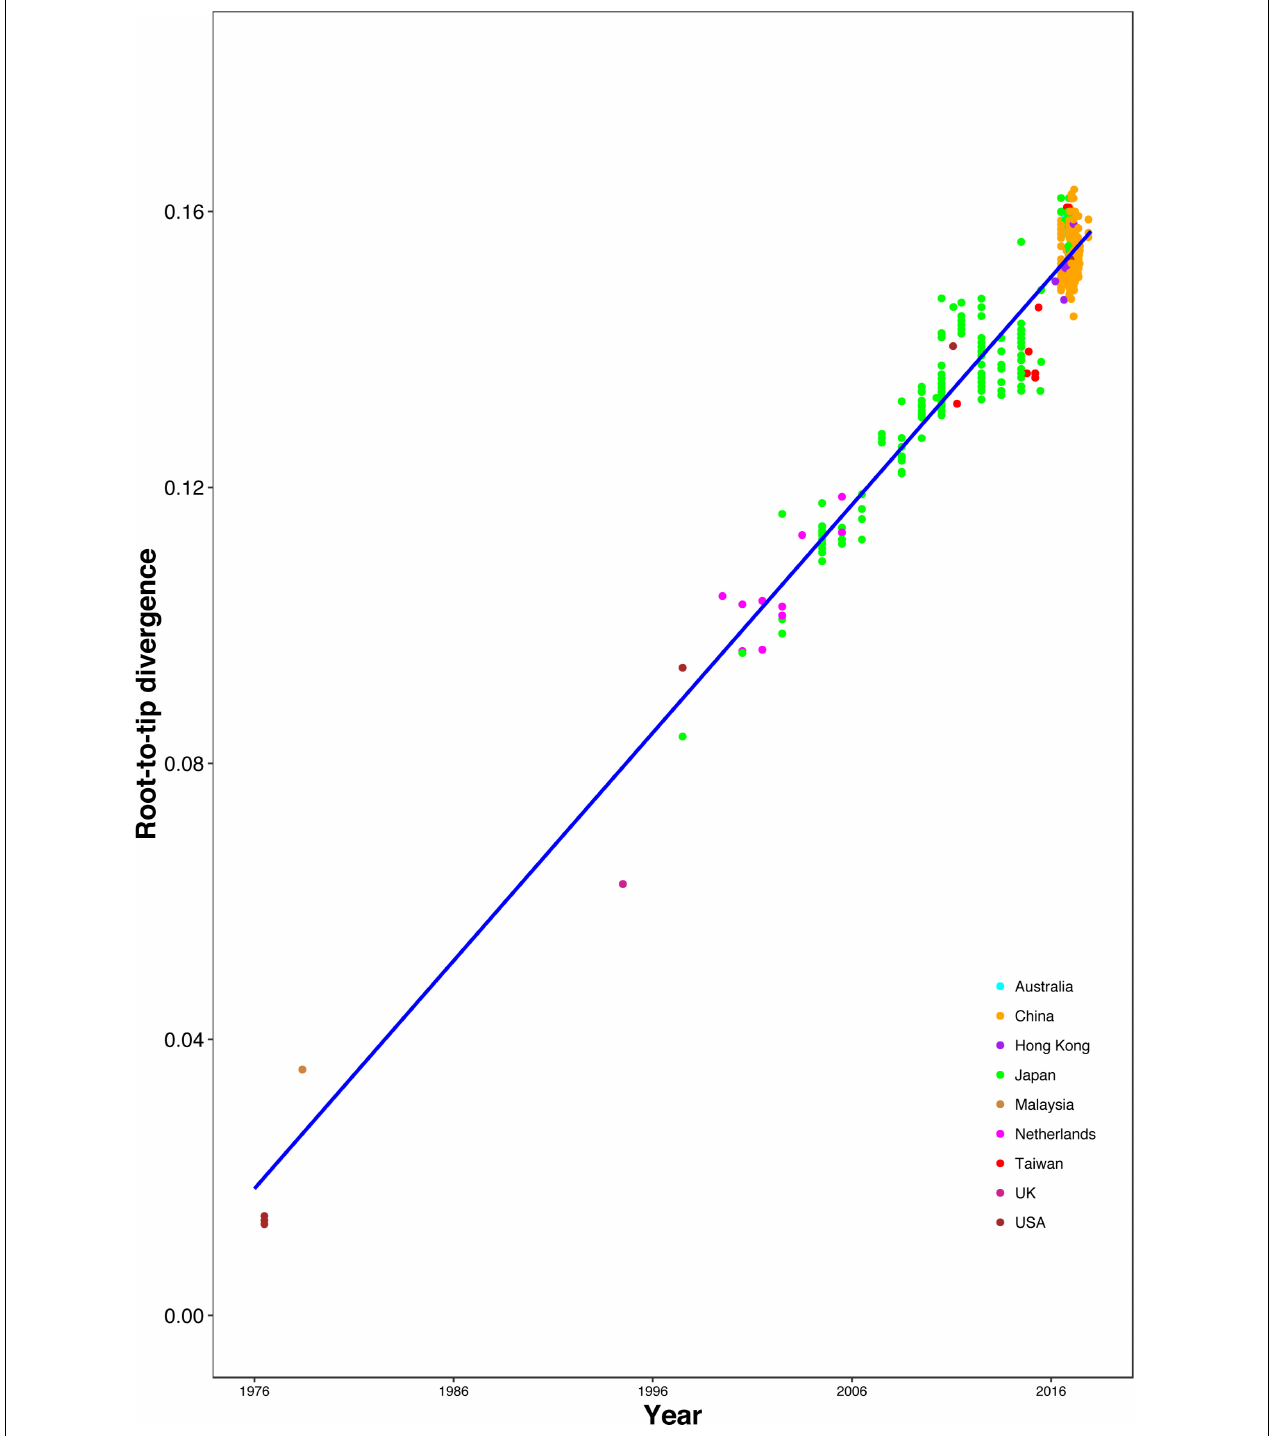
FIGURE 3 | Regression of the root-to-tip genetic distance against year of sampling for the HuNoV GII.2 sequences. Colors indicate different geographic locations.